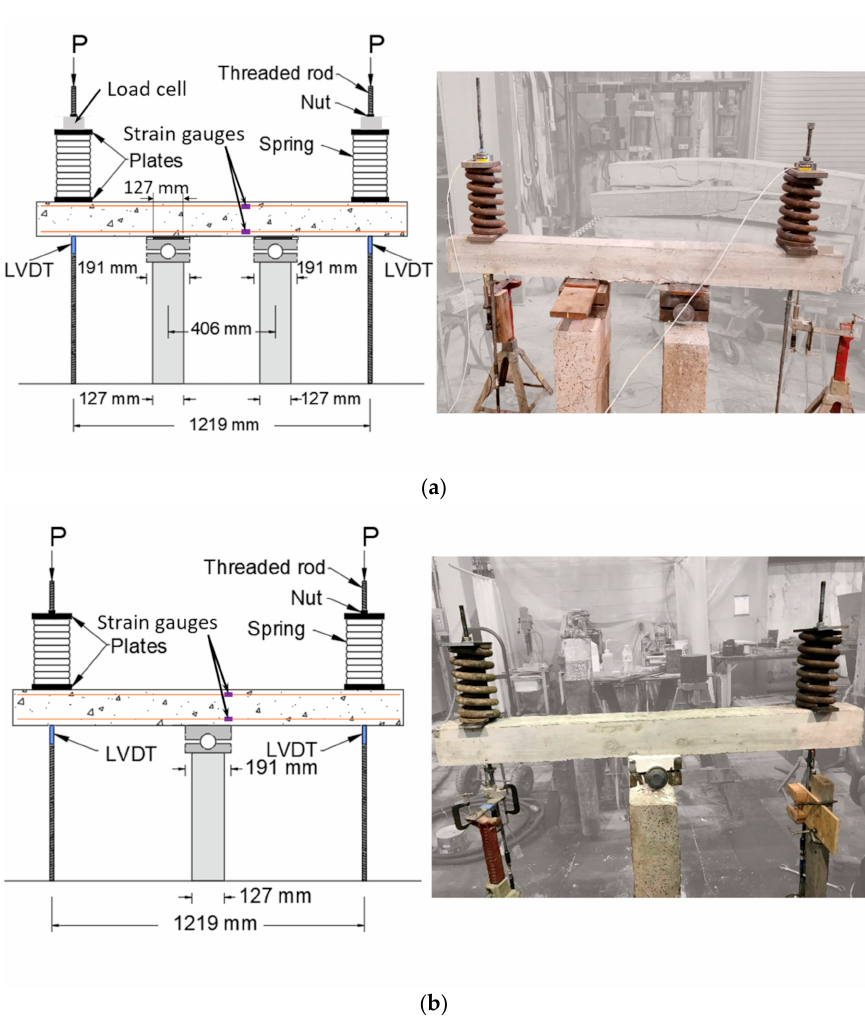
Figure 4. Test setup for ( a ) beam series I and ( b ) beam series II. In beam series II, the reinforcement ratio in the tension zone and compression zones was 1.29% and 0.86%, respectively, and the shear span to depth ratio was 4.3. The rein- forcement ratio and the shear span length were increased so that shear failure could occur before flexural yielding. The point load (P) to reach the ACI 318 [44] shear capacity was 15.80 kN (3551 lb). The load at the yield moment was 19.31 kN (4340 lb) and ultimate moment 20.01 kN (4500 lb). 2.2. Test Setup The test setup for both series used a 1219 mm (4 ft) span between loading points. Beam series I used two supports, each located at 1/3 of the span length (Figure 4a). Beam series II used only one support at mid-span (Figure 4b). Each beam had two through holes created by PVC tubes to allow threaded rods to pass through and load the beam. Each threaded rod was connected to the lab strong floor. The load was applied to the beam by turning the nuts on the top of the threaded rods. Coil springs with a stiffness of 0.84 kN/m (4800 lb/in) were added to help maintain a constant applied load.